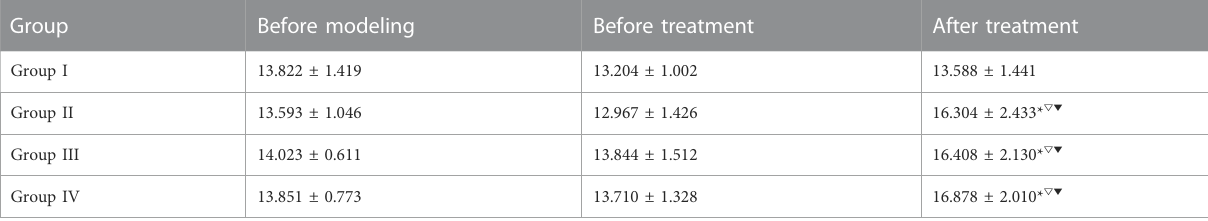
TABLE 2 The TNF- α content in each group (pg/mL, ‾ x ± s). Group